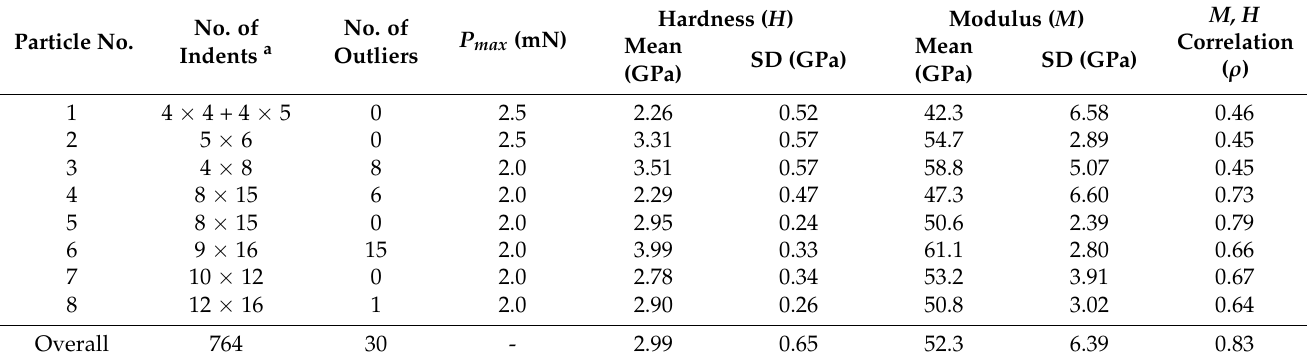
Table 4. Summary of indentation properties of precipitate obtained from modified EICP solution.